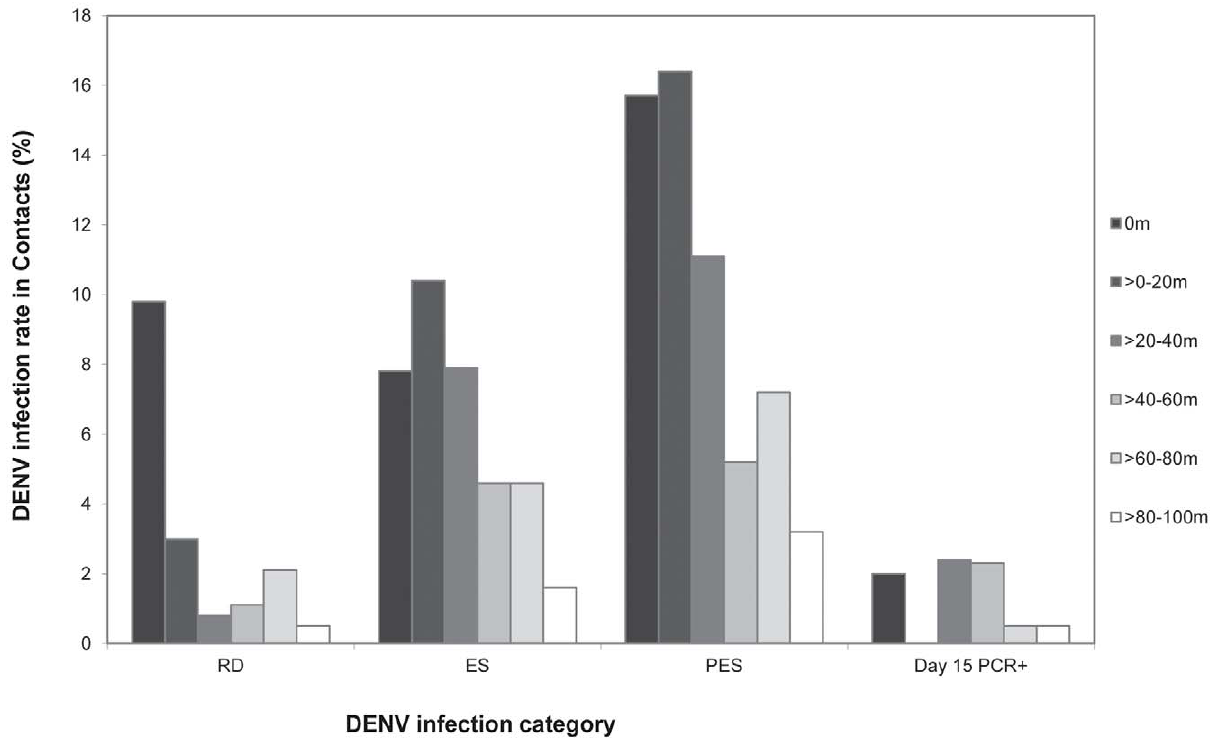
Figure 2. Focal aggregation of DENV-infected child contacts in positive clusters categorized by estimated time of infection. RD=recent dengue (N=15); ES=enrollment seroconversion (N=41); PES=post-enrollment seroconversion (N=63); day 15 PCR-positive